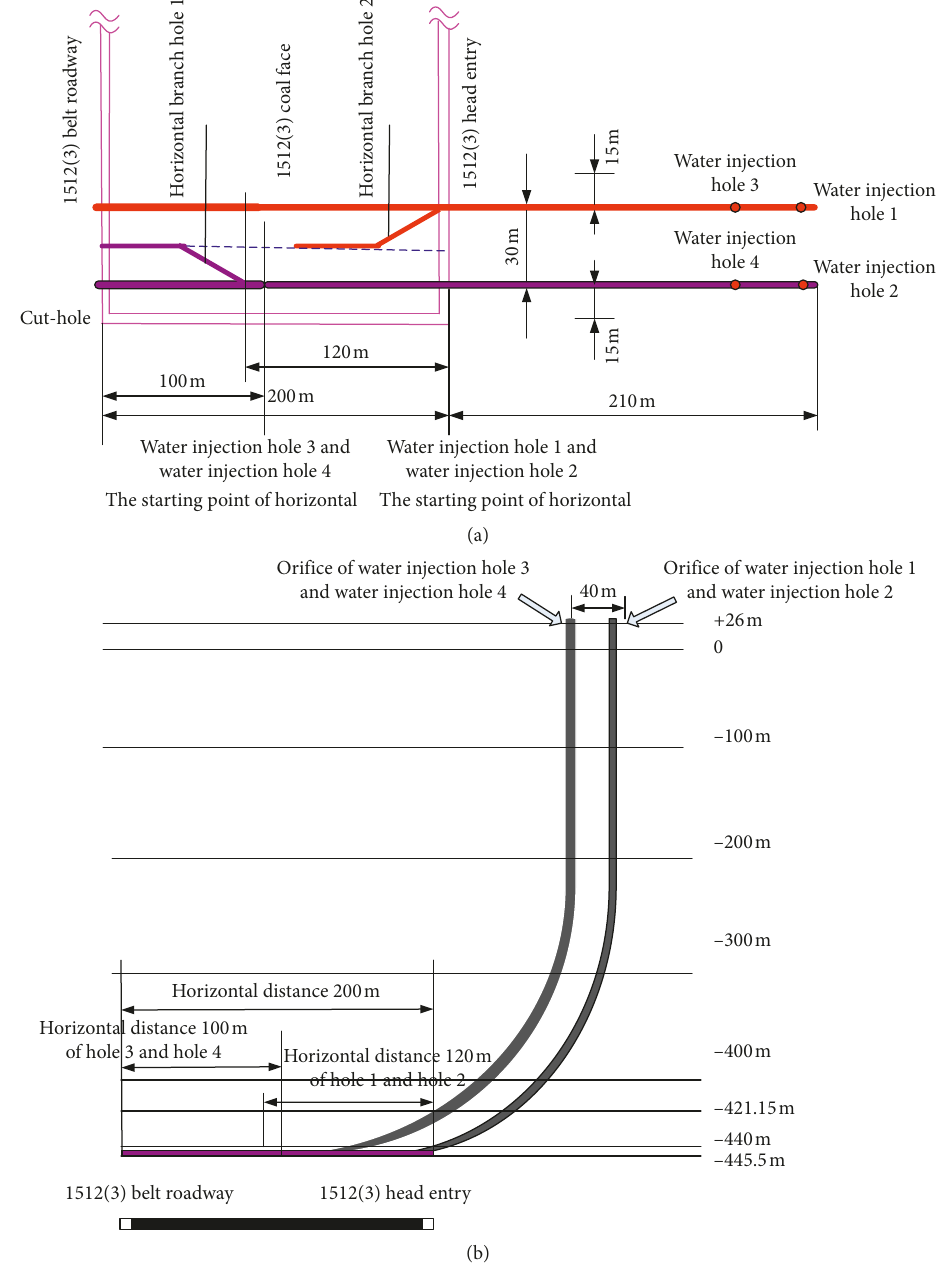
Figure 5: Ground J-type grouting hole distribution: (a) plan and (b) profile